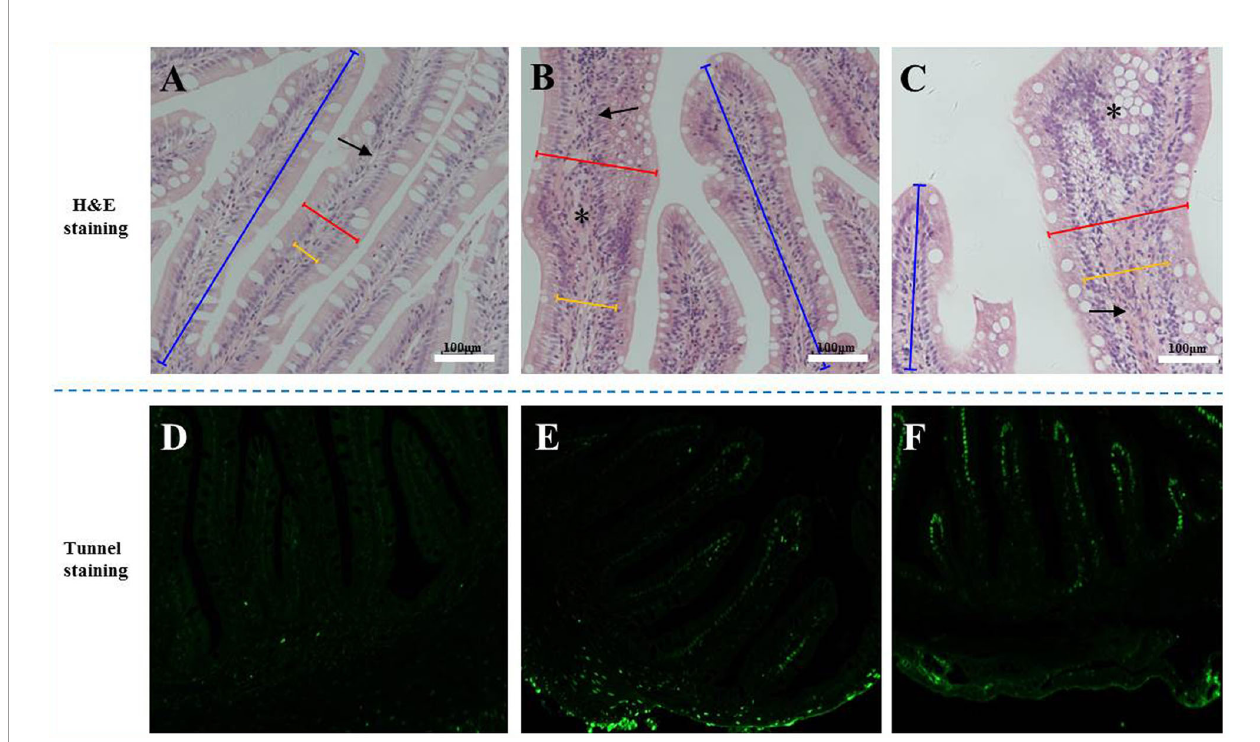
FIGURE 1 | The tissue staining in the distal intestine sections of pearl gentian grouper. Representative histomorphological images from H&E (A – C) and Tunnel sections (D – F) of distal intestine of juvenile grouper on FM (A, D) , SBM20 (B, E) , and SBM40 (C, F) diets. (A – C) Representative images of increased width and cellular (leucocyte) in fi ltration (asterisk) of the lamina propria (arrows) in SBM20 and SBM40 groups. (D – F) The green fl uorescence represented apoptosis cell; blue bar, the height of plica; red bar, the width of plica; and yellow bar, the width of lamina propria. FM, fi sh meal control group; SBM20, 20% SBM protein replacement level to FM protein; SBM40, 40% SBM protein replacement level to FM protein. Arrow-lamina propria; asterisk-in fl ammatory in fi ltration.